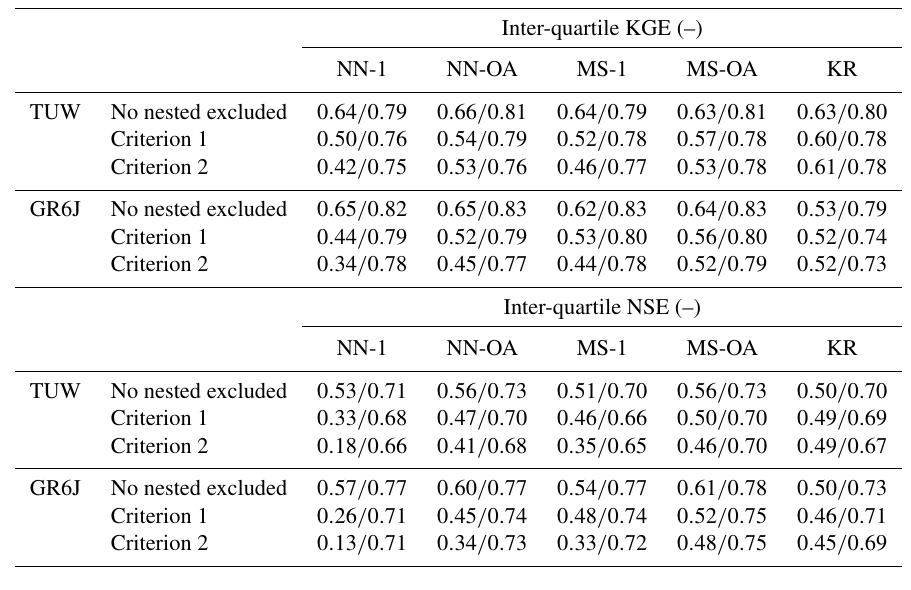
Table 5. Inter-quartile values of Kling–Gupta and Nash–Sutcliffe efficiencies when regionalising TUW and GR6J models excluding or not excluding nested donor